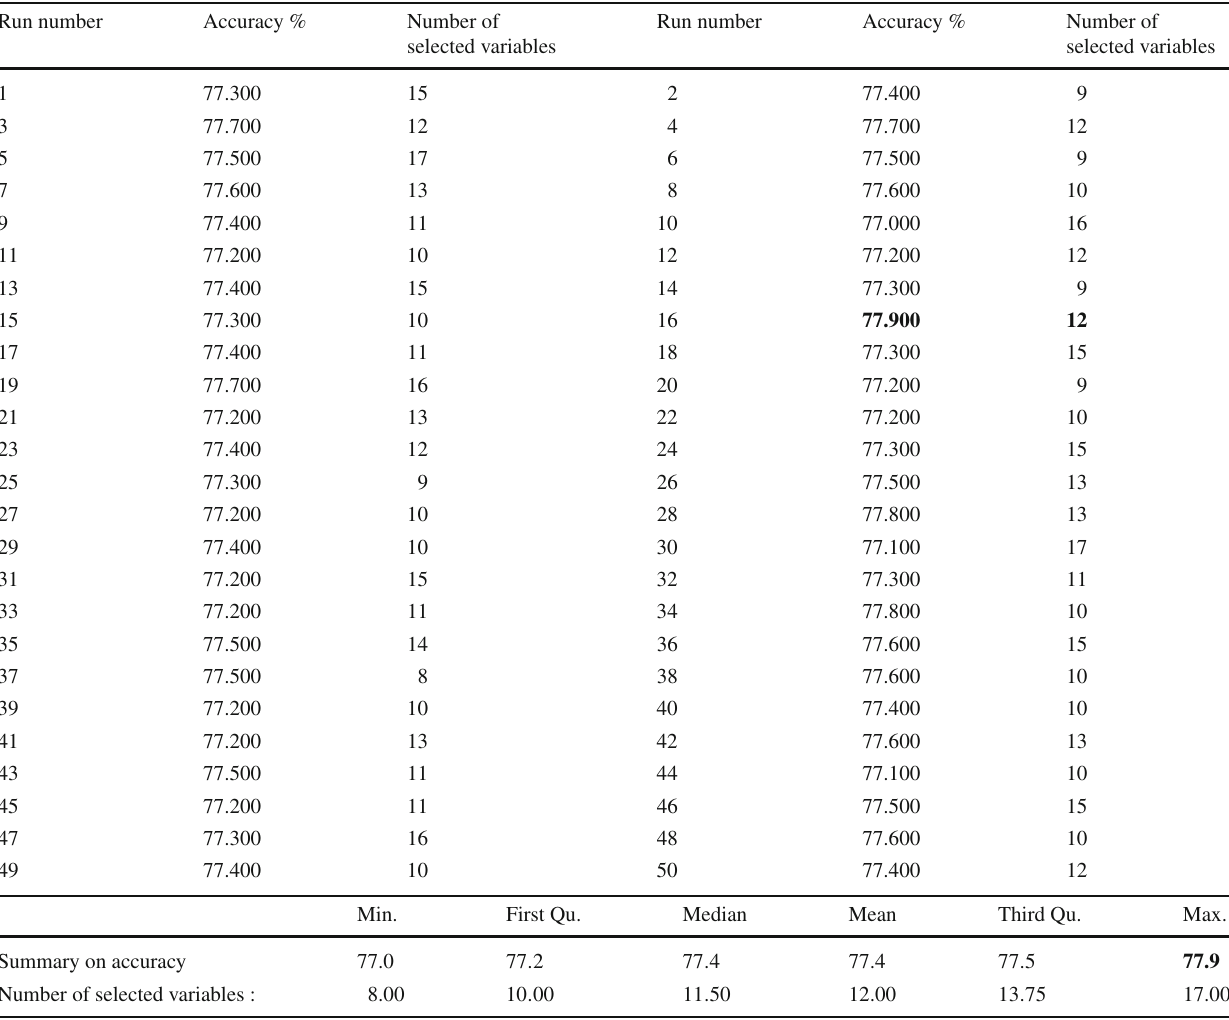
Table 5 The results of 50 run of SLS+SVM on German